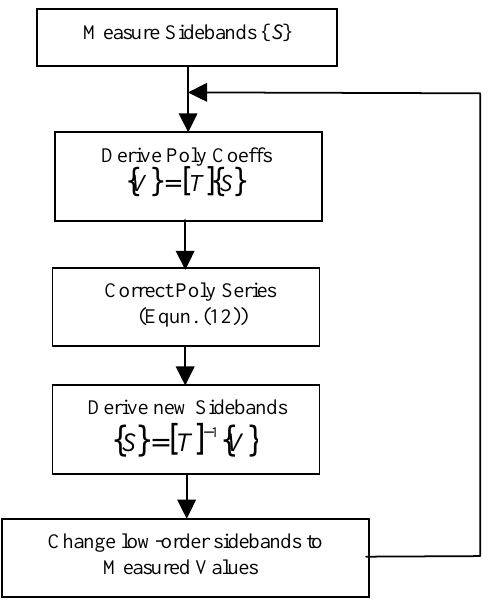
Fig. 2. Flow diagram for iterative improvement of measured uni- form-beam LDV sine-scan